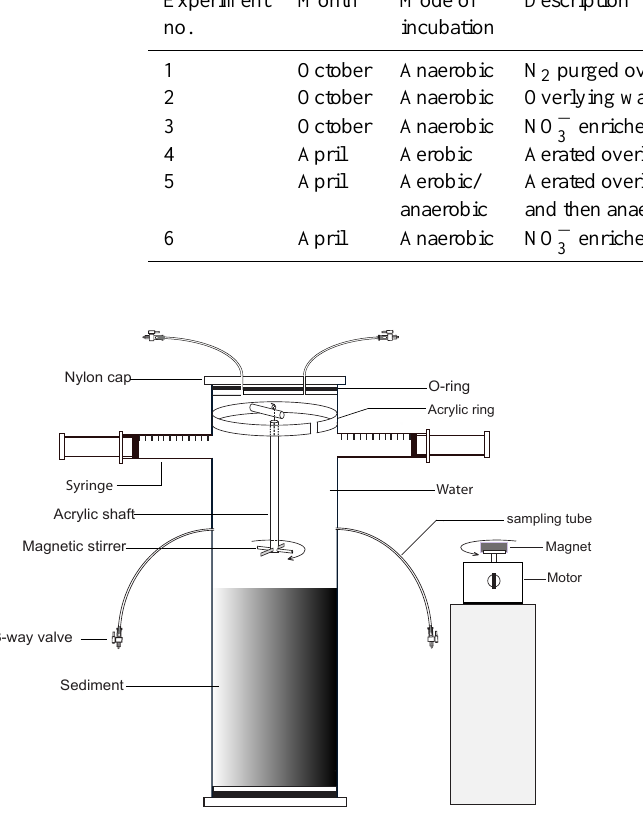
Fig. 2. Figure 2. Experimental design for the intact-core